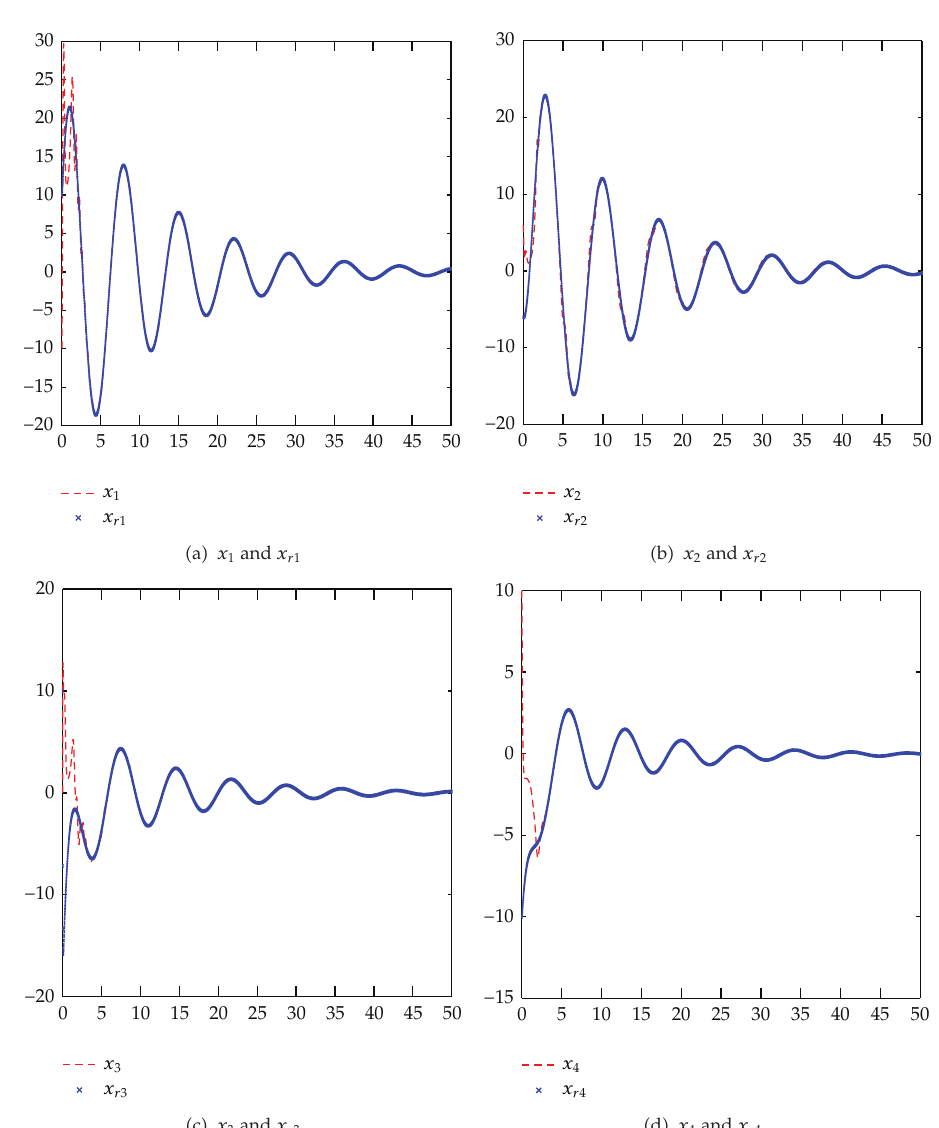
Figure 4: Comparison of the corresponding variables in the controlled hyperchaotic R¨ossler system and its reference system: (cid:6) a (cid:7) x 1 and x r 1 ; (cid:6) b (cid:7) x 2 and x r 2 ; (cid:6) c (cid:7) x 3 and x r 3 ; (cid:6) d (cid:7) x 4 and x r 4 . The estimation system of uncertain parameters